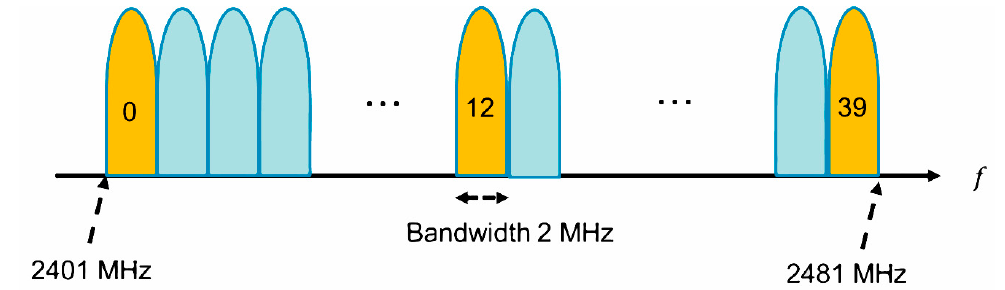
Figure 1. Example of a medical and healthcare system using WBAN.